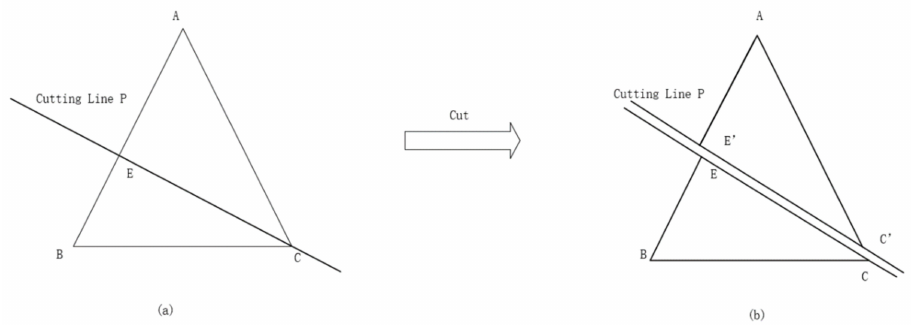
Figure 8. Triangle clipping method 2. ( a ) Triangle before cutting and ( b ) triangle after cutting.